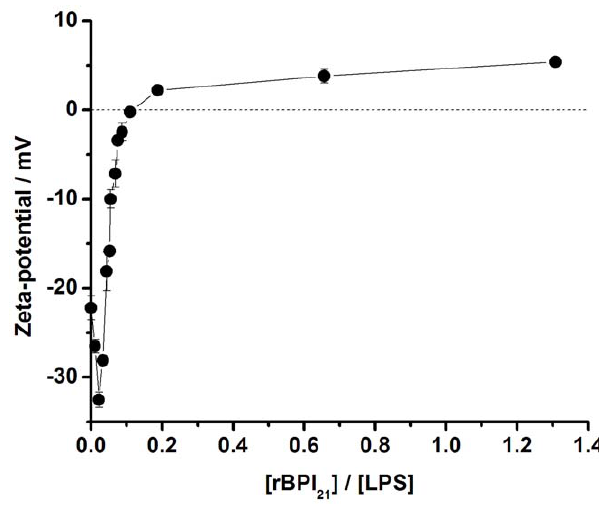
Figure 3. Zeta-potential for LPS aggregates in the presence of rBPI 21 . Bars represent the zeta-potential range from two independent experiments.